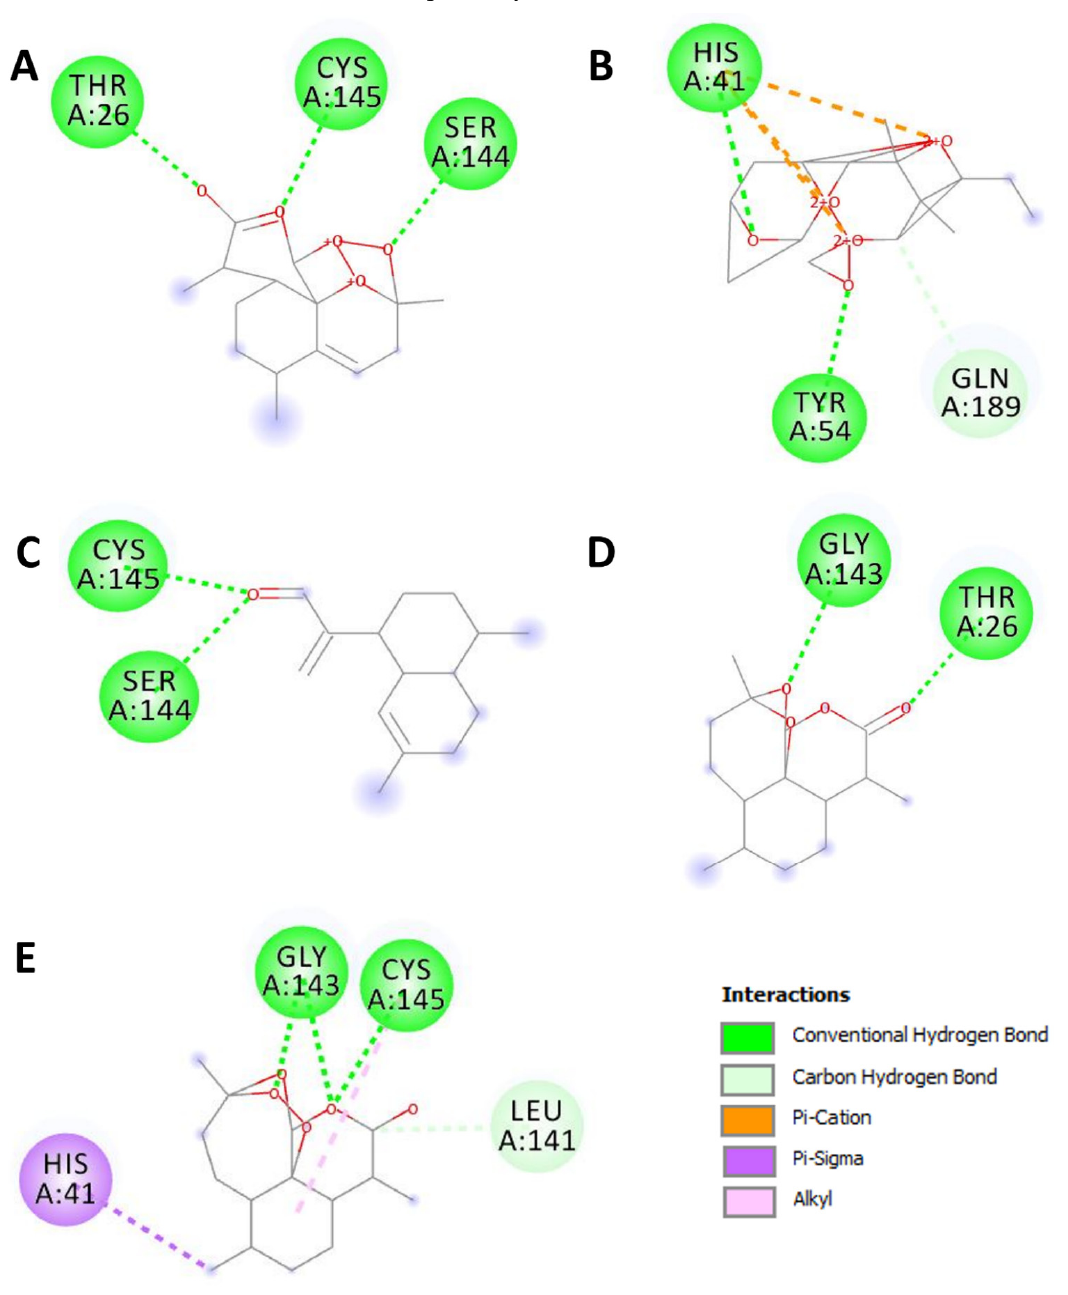
Figure 3. 2D diagrams of the closest interactions between the Artemisia campestris selected compounds (( A ) artemisinin, ( B ) acetate of dihydroartemisinin, ( C ) artemisinic aldehyde, ( D ) deoxyartemisinin, and ( E ) dihydroartemisinin) and the main protease (Mpro) of SARS-CoV-2 (6LU7) inducing COVID-19. A molecular docking analysis was also used to predict the binding affinities between artemisinin and the seventeen ACE2 variants reported to bind with the coronavirus spike